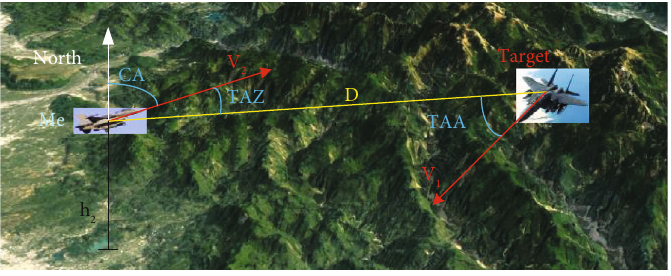
Figure 1: The picture is a spatial location diagram showing relatively low correlation between parameters and tactical intentions. CA is my course angle, TAA is the target ’ s approaching angle, TAZ is the target ’ s azimuth angle, D is the distance between two sides, h2 is the altitude of my aircraft, v1 is the target speed, and v1 is the speed of my